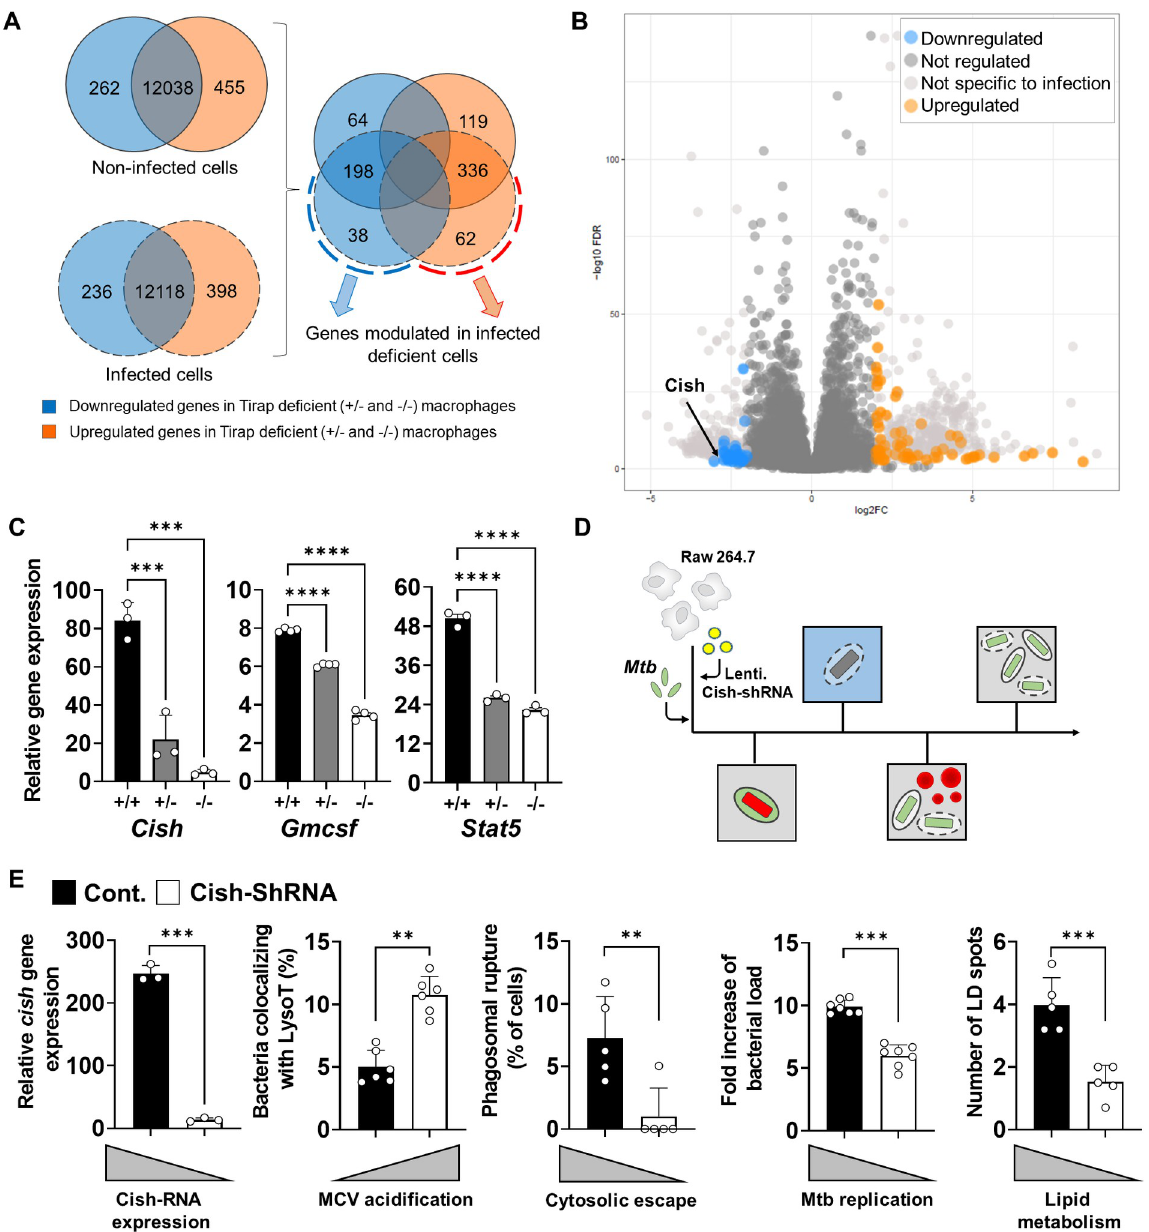
Fig 4. Identification of differentially regulated genes between +/+, +/- and -/- BMDMs during Mtb infection. ( A ) Total RNA was extracted from non-infected and infected (3 h) WT, Tirap +/- and Tirap -/- BMDMs and sequenced with the Illumina system and Deseq2 analysis as described in the Materials and Methods section. ( B ) Volcano plot of RNAseq data from non-infected versus infected cells showing the adjusted p-value (false discovery rate, FDR -log10) versus fold change, FC (log2). The 100 genes with an FDR < 0.01 and FC > 2 are shown in blue and orange for downregulated and upregulated genes, respectively. ( C ) Histograms showing mean ± SEM of gene expression levels in BMDMs from WT, Tirap +/- and Tirap -/- mice 3 hpi. Cish and Gmcsf expression was quantified by quantitative RT-PCR. Stat5 expression level is reported from RNAseq data. ( D ) Schema of the different subcellular events studied in infected RAW264.7 cells silenced for Cish gene expression. ( E ) RAW264.7 cells were grown in 384-well plates, infected with Mtb H37Rv (MOI of 2) and analyzed by automated confocal microscopy. Histograms show the quantification of Cish gene expression and different phenotypic subcellular events during Mtb infection of WT (Cont) and silenced (Cish-shRNA) RAW264.7 cells. �� P value < 0.01, ��� P value < 0.001, ���� P value < 0.0001, as determined by one-way ANOVA test.